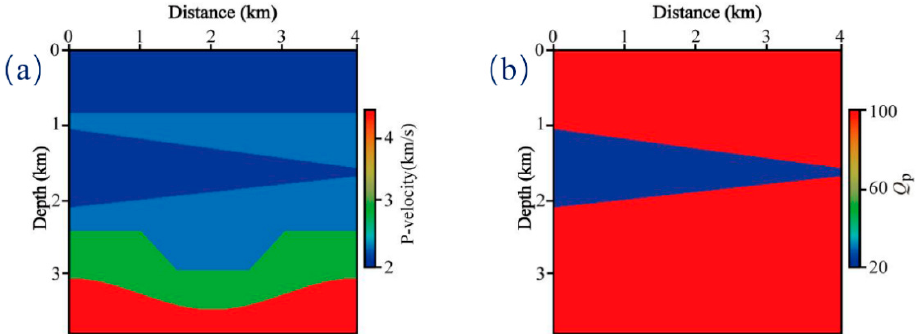
Figure 1. Sag model. ( a ) P − wave velocity model and ( b ) P − wave quality factor Q p model.